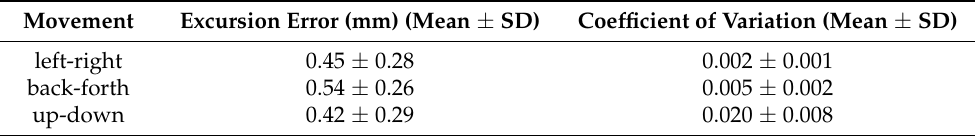
Table 1. Results of the in vitro reproducibility tests. The excursion error [mm] was used as a measure of the accuracy for the set-up; the coefficient of variation as a measure of its precision.